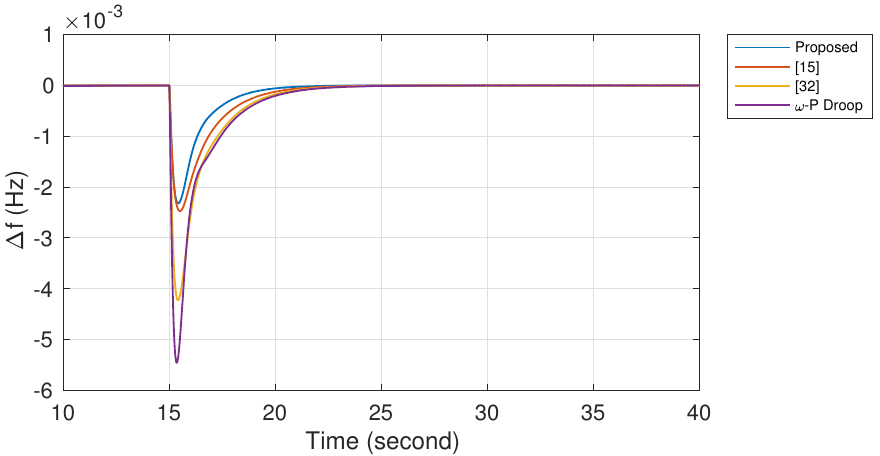
Figure 14. Comparison of the frequency recovery and frequency nadir performance of the proposed control system with existing control systems.